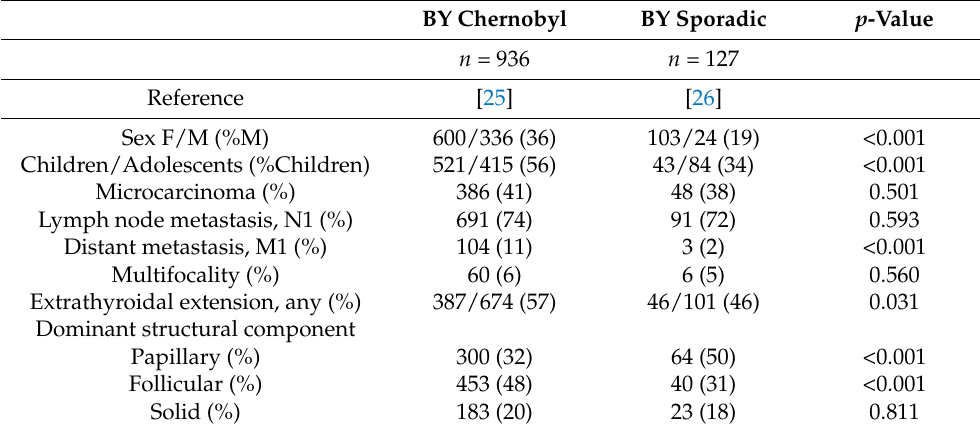
Table 1. Clinicopathological characteristics of thyroid cancer in children and adolescents from Belarus (post-Chernobyl and sporadic